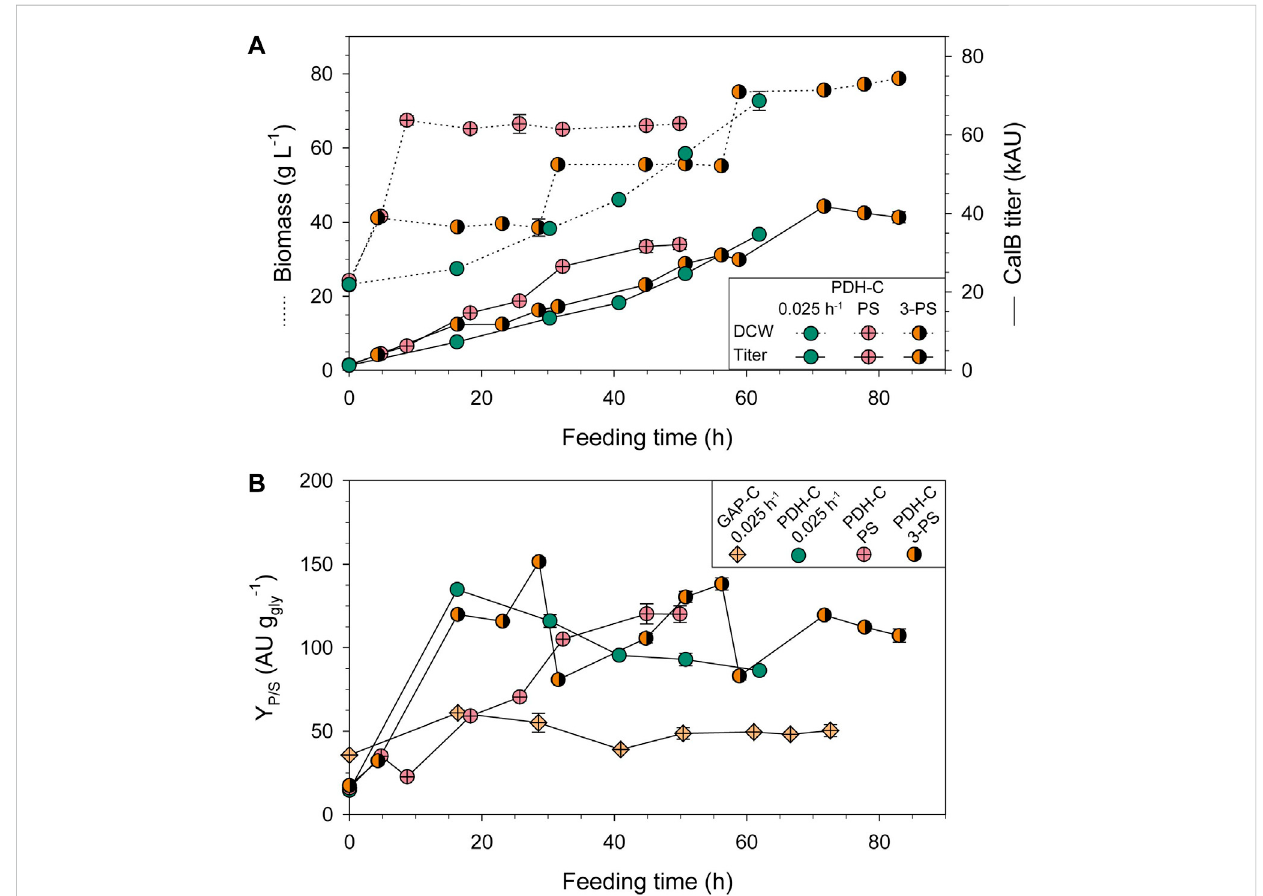
FIGURE 5 Optimization of PDH-C fed-batch cultivations through pseudo-starving conditions compared to the benchmark cultivation of GAP-C at low µ (0.025 h -1 ). (A) BiomassandCalBtiterevolutionovertime ofPDH-Coptimizedcultivations(PSand3-PS)andatlowµ(0.025 h -1 ). (B) Producttosubstrate yield (Y P/S ) of the PDH-C optimized cultivations compared to PDH-C and GAP-C at low µ (0.025 h -1 ). The errors bars represent the standard deviation of the